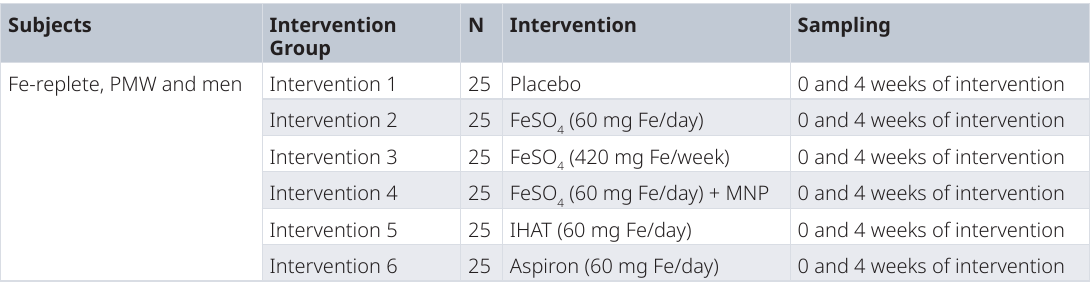
Table 1. Intervention groups for Phase I of the Safe Iron